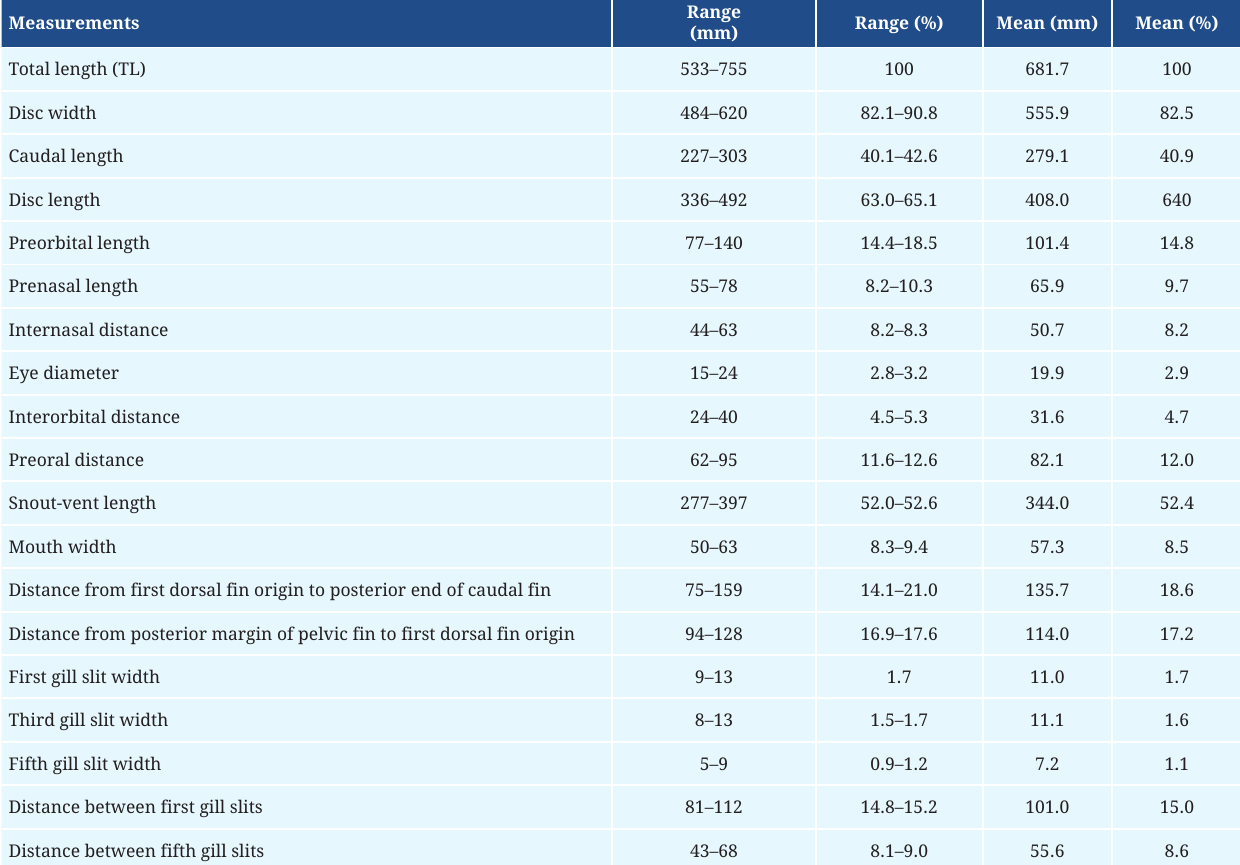
TABLE 6 | Neurocranial measurements in percentages of nasobasal length (% NL) of male and female specimens of Atlantoraja cyclophora